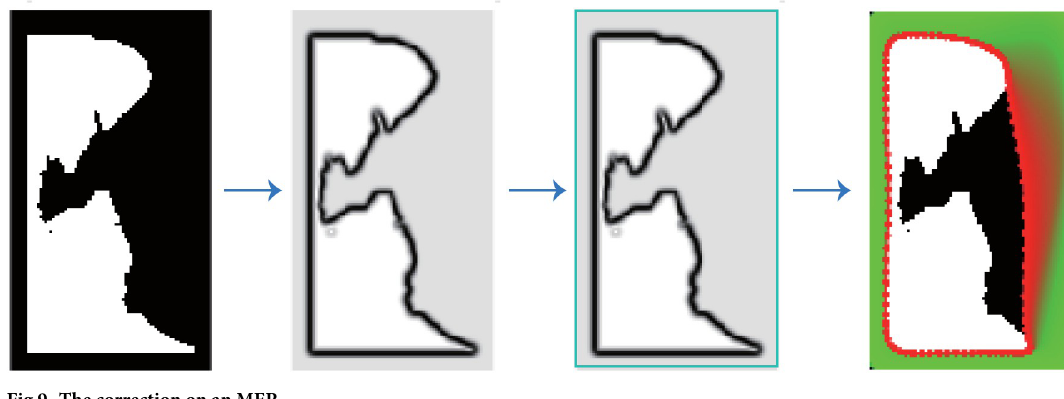
Fig 9. The correction on an MER.